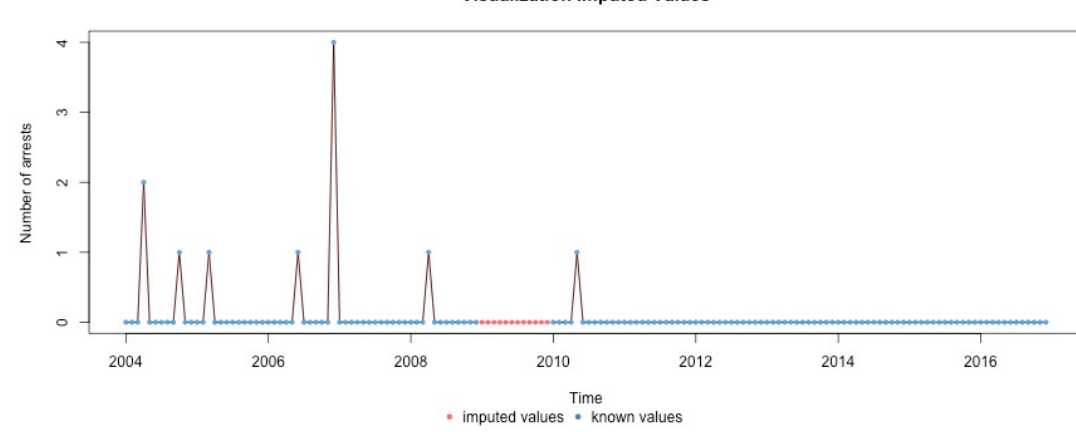
Figure A25. Heroin organized neighboring countries nationals crime arrests 2004–2016 in the Czech Republic—imputed missing values.